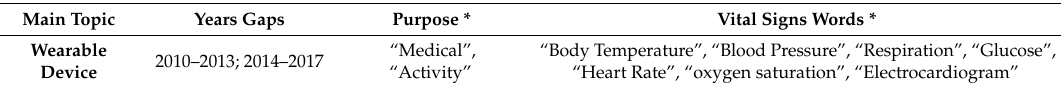
Table 1. WHDs Survey topics and restrictions.